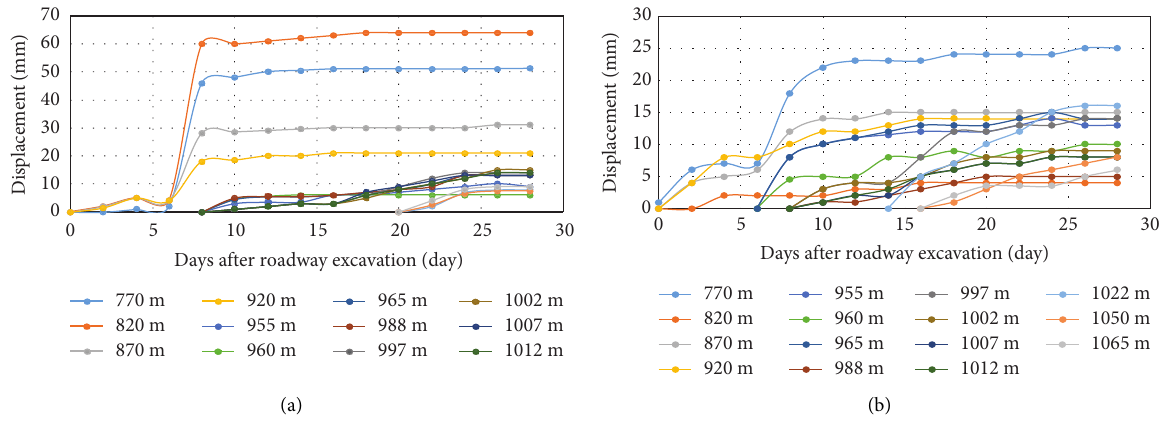
Figure 14: Deformation of roadways when using different layouts. (a) Roof and floor approach. (b) Two-sided